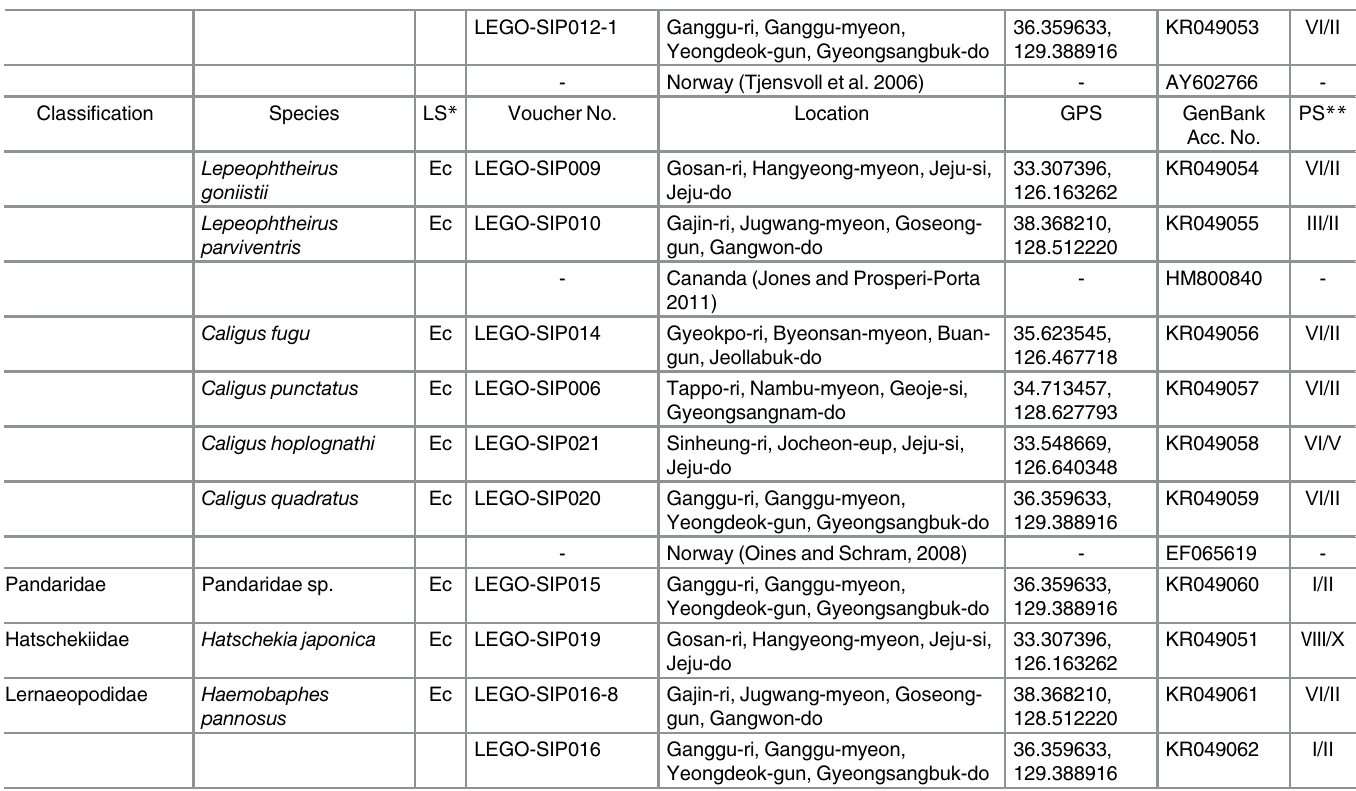
Refer to Table 2 for primer sequences and lengths corresponding to the primer numbers I – X.